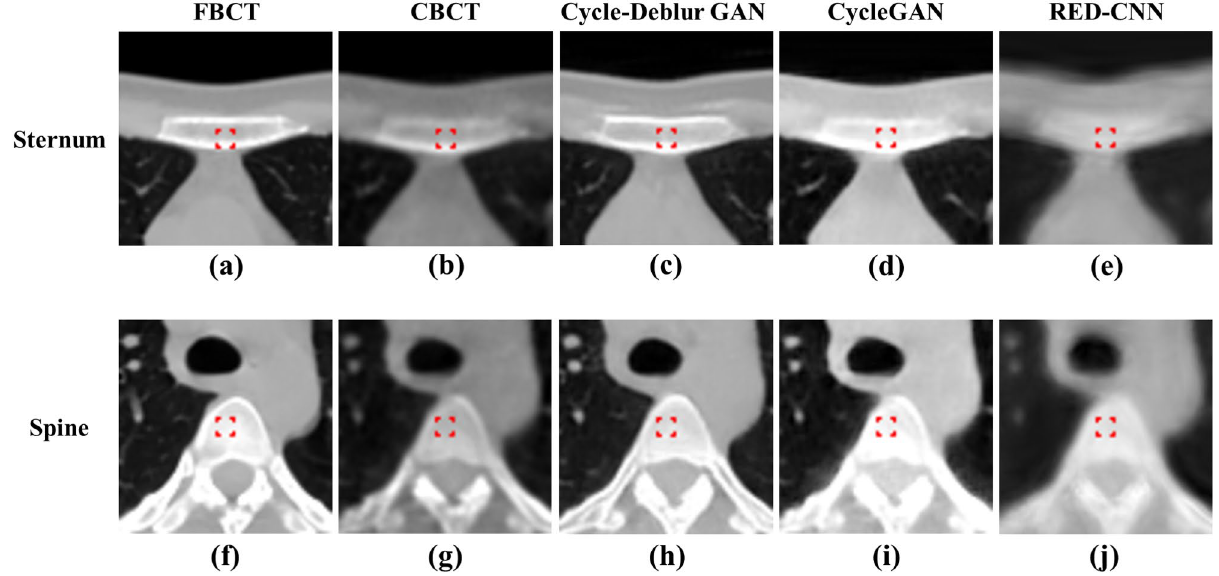
Figure 8. The bony structure ROIs of the sternum and spinal process for quantitative evaluation are shown in ( a , f ): FBCT, ( b , g ): CBCT, ( c , h ): Cycle-Deblur GAN, ( d , i ): CycleGAN and ( e , j ): RED-CNN were performed by XVI software and PMOD software. (W = 1450, L = − 225 for all CT images).